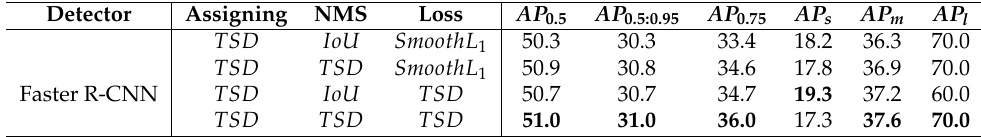
Table 2. Ablation study on Pest24 validation